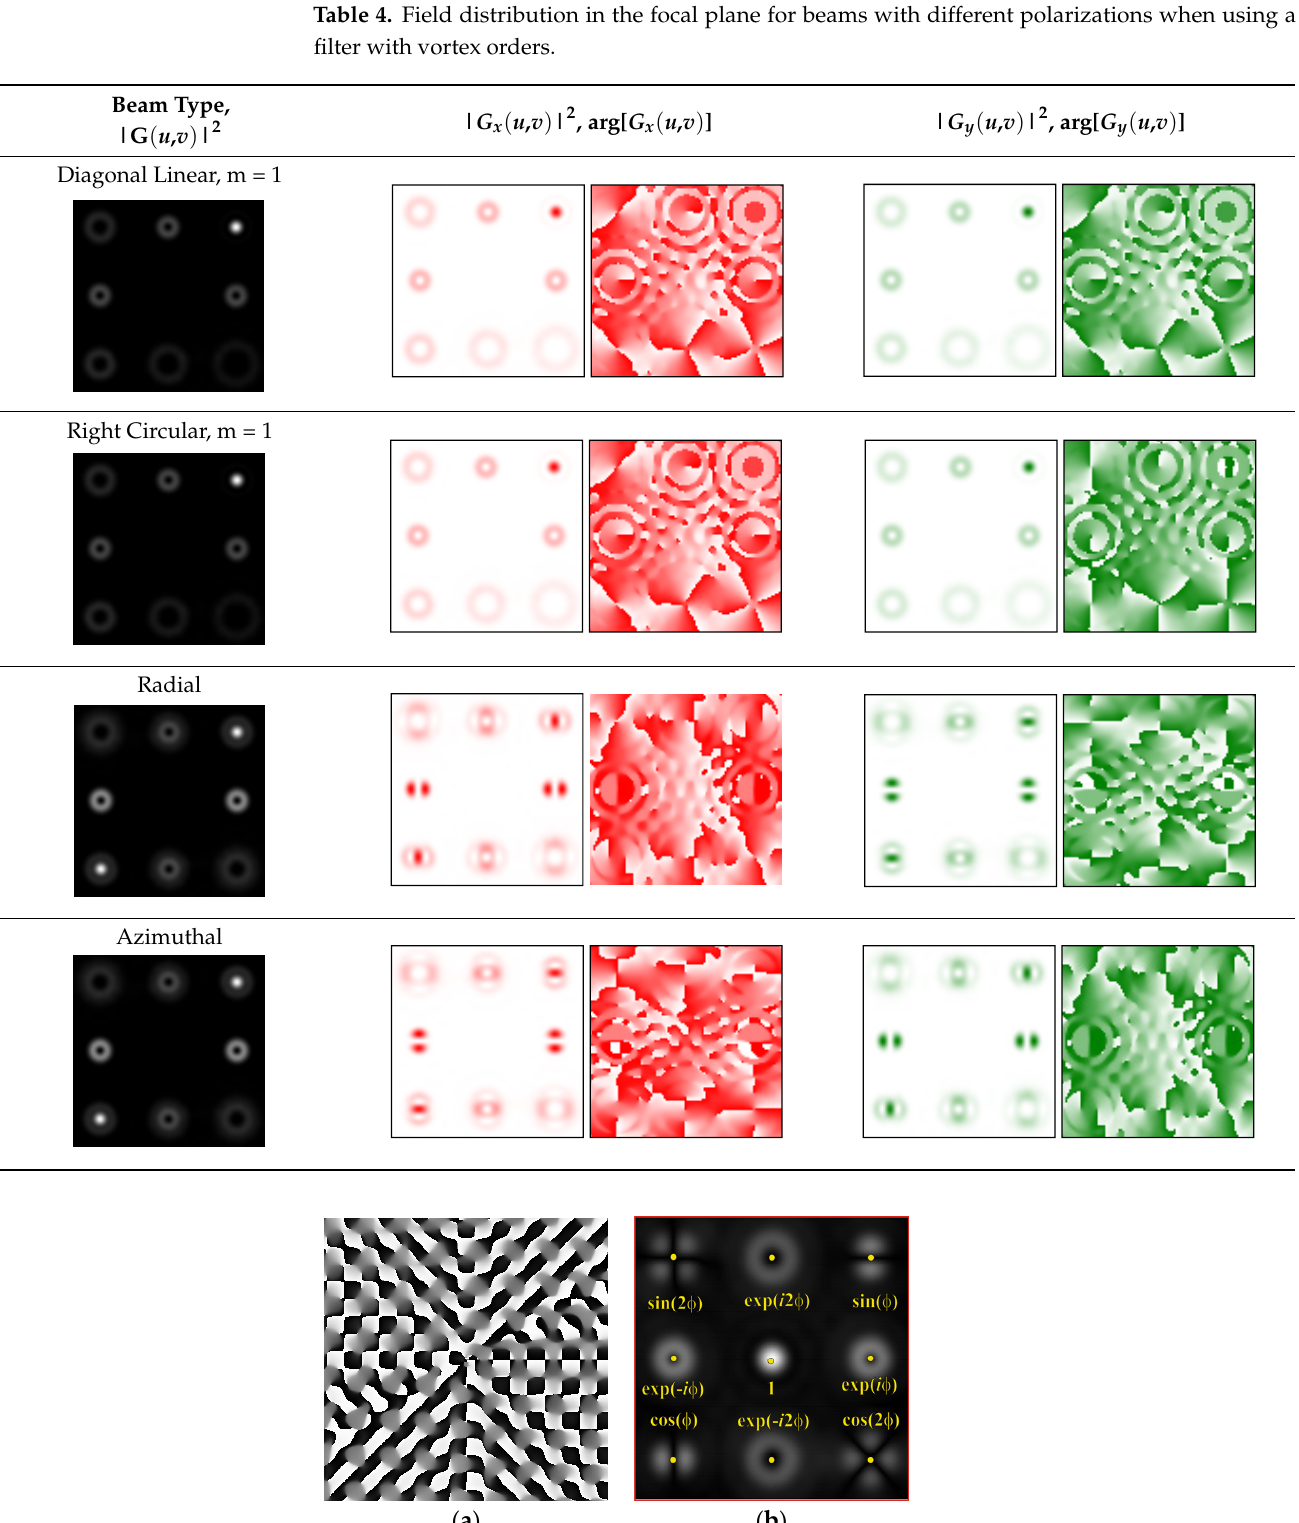
Figure 5. Nine-channel DOE, matched with optical vortices and their superpositions: ( a ) the form of the phase function, and ( b ) the correspondence of diffraction orders in the focal plane. The action of the diffraction orders matched with cos ( q φ ) and sin ( q φ ) has a different effect for different types of cylindrical polarization.